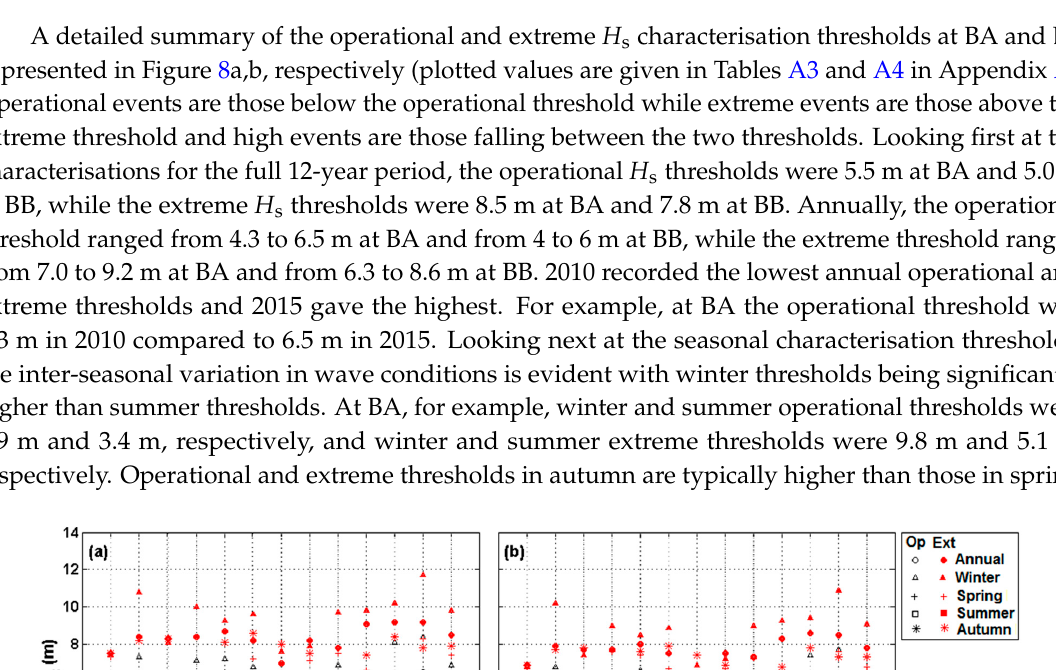
s (m) for mean and maximum